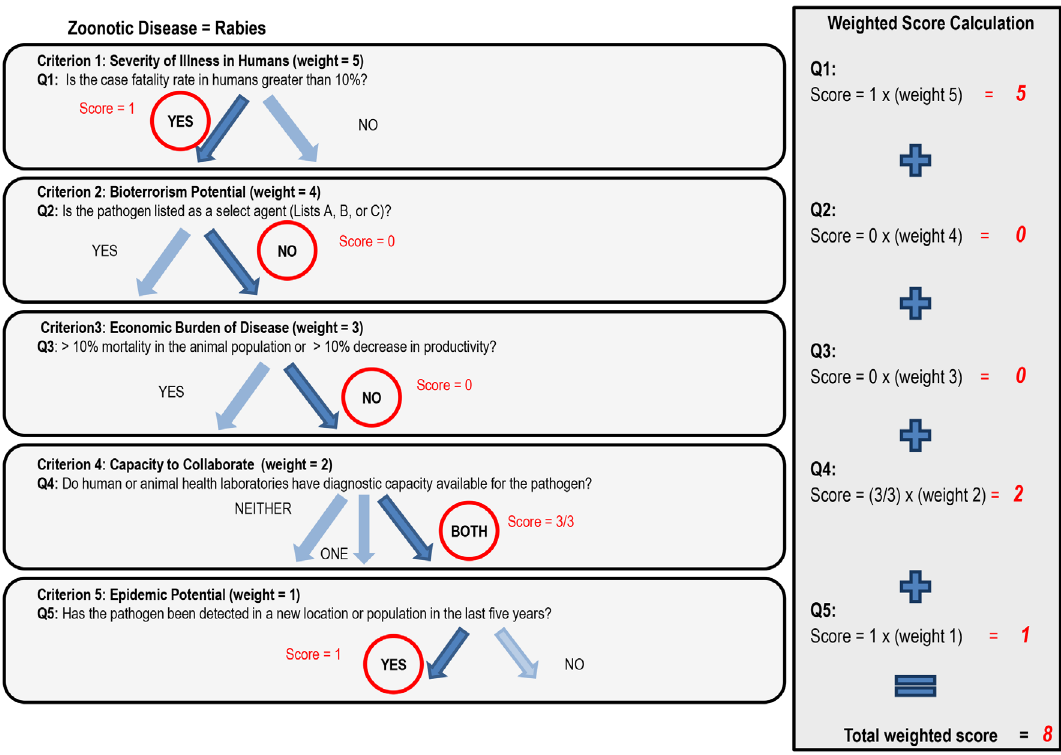
Figure 2. An example of decision tree analysis (Step 5 in the OHZDP Tool) for rabies. The criteria and questions shown are examples only, provided to show the process of how each zoonotic disease is scored. Criteria and questions are developed and given weights by the stakeholder representatives during the facilitated group work in Steps 2–5. Weighted scores for each question are summed to give the total weighted score for each pathogen; total weighted scores are normalized in relation to the maximum pathogen score to give a final ranked list.